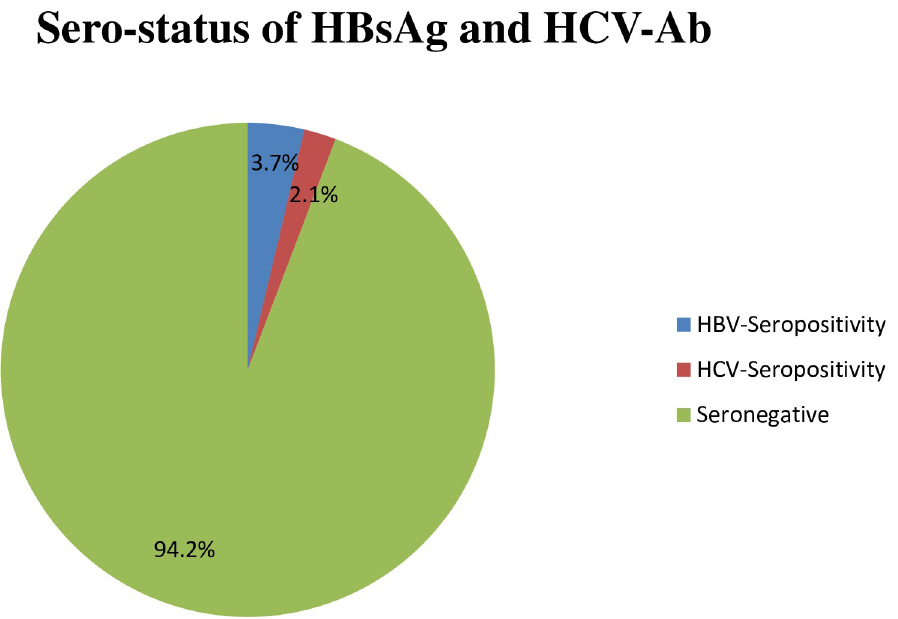
Fig 1. Seroprevalence of HBsAg and HCV-Ab among pregnant women attending maternity wards at BKMC Shahmansoor and DHQ Hospital Swabi, Khyber Pakhtunkhwa, Pakistan. None of the mothers were co-infected with HBV and HCV. The chi-square analysis of the association between different risk factors and the prevalence of HBV and HCV revealed that dental extraction (P = 0.001) and blood transfusion (P = 0.0005) (Table 1) were the significant risk factors associated with HBV prevalence. Correspondingly, the sociodemographic characteristics of pregnant mothers such as residential status (P = 0.017) and educational level (P = 0.048) (Table 2) were also significantly allied with HBV infection.